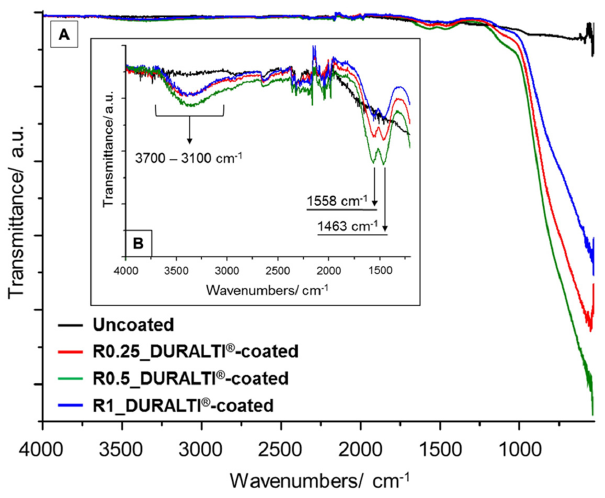
Figure 1. FTIR spectra of R0.25, R0.5 and R1 uncoated and DURALTI ® -coated aluminum disks in the range between ( A ) 4000–530 cm − 1 and 4000–1200 cm − 1 ( B ).